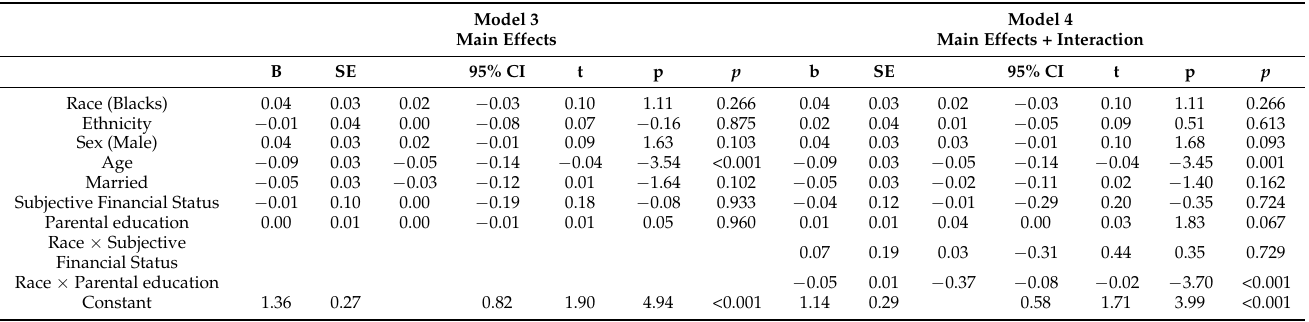
Table 3. Linear regressions